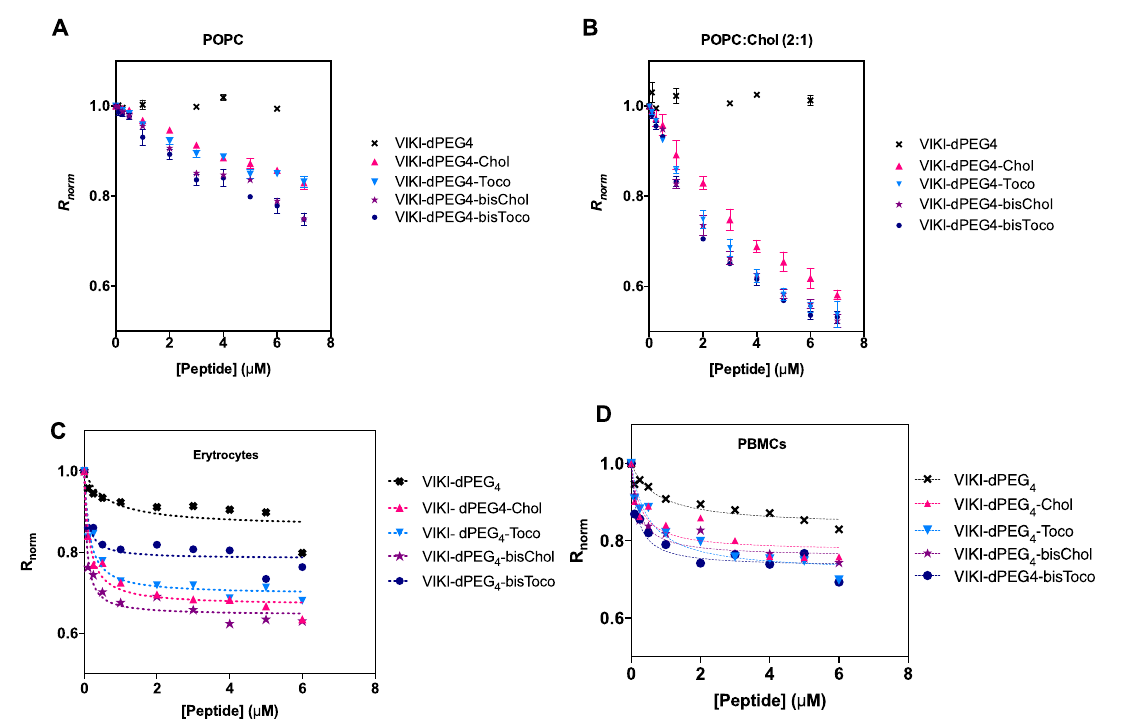
Figure 3. Membrane binding profiles of the VIKI-peptides to ( A ) POPC and ( B ) POPC:Chol (2:1) LUV, and to ( C ) erythrocytes and ( D ) PBMCs, assessed using the fluorescence probe di-8-ANEPPS. Binding profiles were obtained by plotting the di-8-ANEPPS excitation ratio, R (I 455 /I 525 , normalized to the initial value), as a function of peptide concentration. DMSO, cholesterol and tocopherol were also tested, as controls, and no significant changes in dipole potential were observed (data not shown).